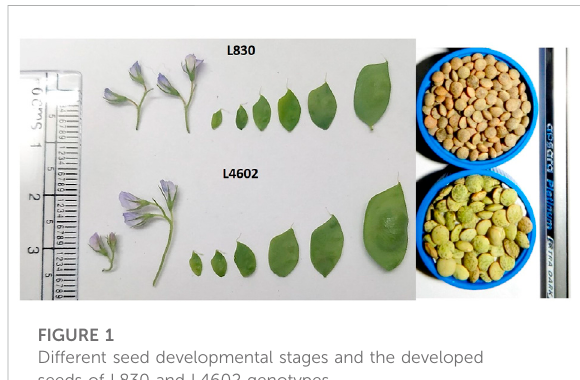
FIGURE 1 Different seed developmental stages and the developed seeds of L830 and L4602 genotypes.